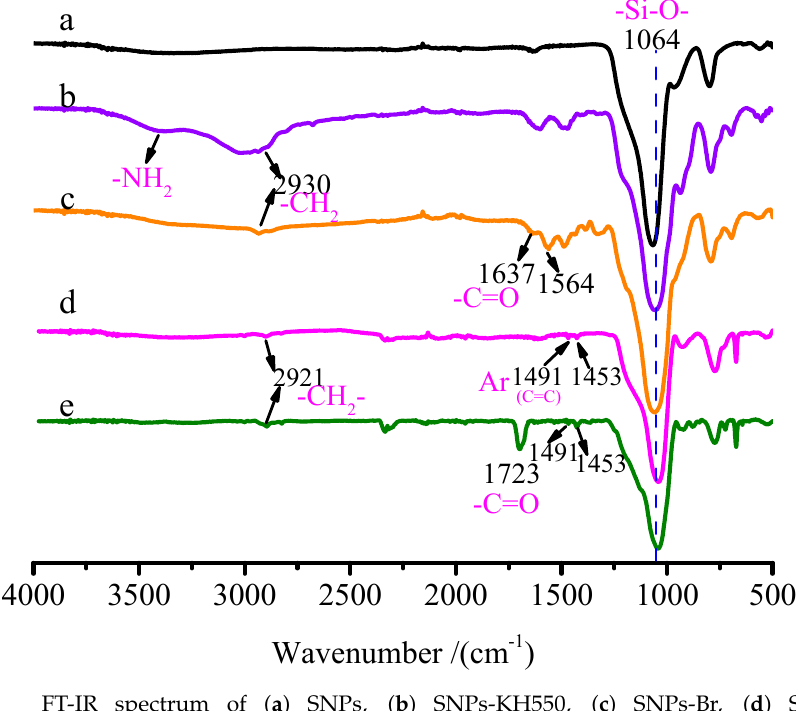
Figure Figure 2. FT-IR spectrum of ( a ) SNPs, ( b ) SNPs-KH550, ( c ) SNPs-Br, ( d ) SNPs- g -PS, ( e ) SNPs- g -PS- b - PHEMA- co -PHEMA-RhB.